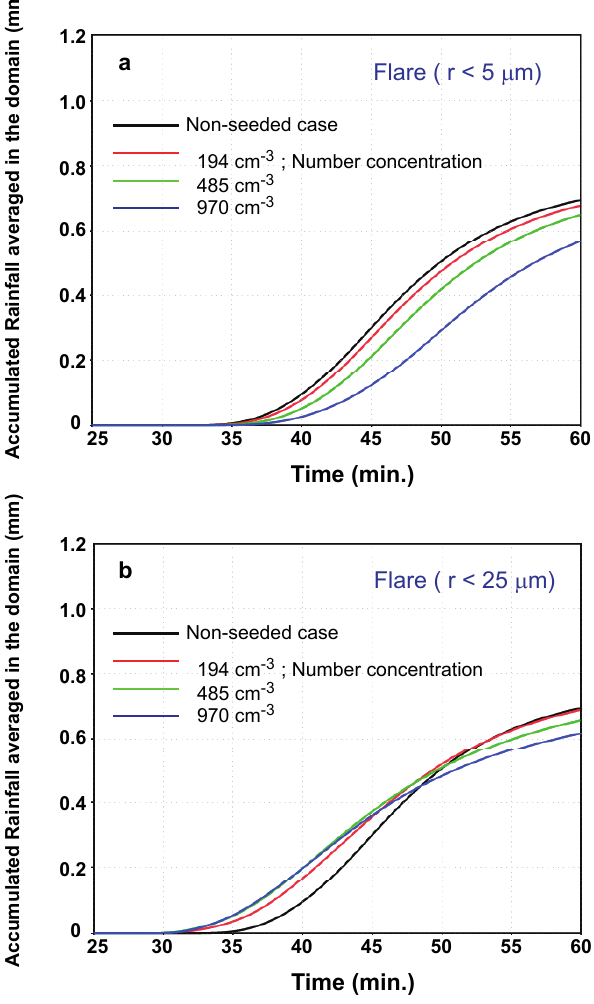
Fig. 12. Temporal change of accumulated surface rainfall averaged over the domain. Shallow convective cloud is seeded with flare par- ticles up to 5µm (a) or up to 25µm (b) in radius. The black line indi- cates the accumulated surface rainfall for the non-seeded case. For seeded cases, different total number concentrations of flare particles are seeded under the cloud base: 194cm − 3 (red line), 485cm − 3 (green line), or 970cm − 3 (blue